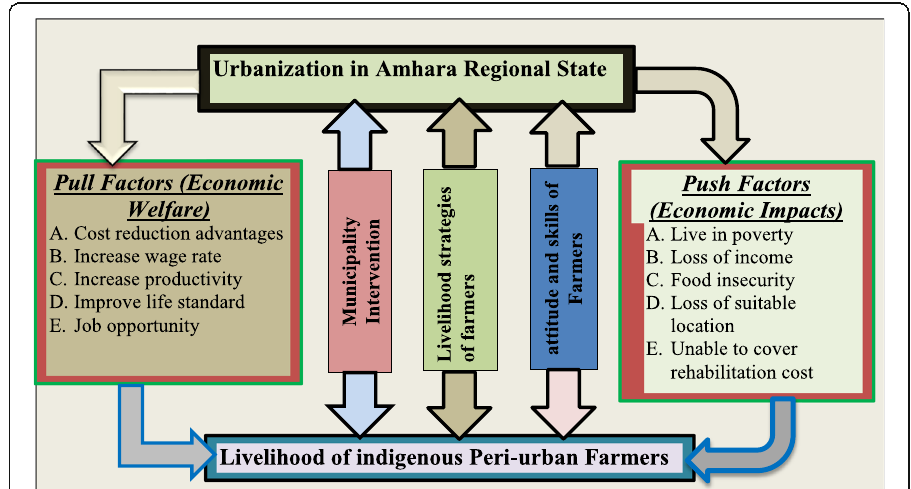
Fig. 1 The economic welfare and impact of urbanization on livelihood of peri-urban